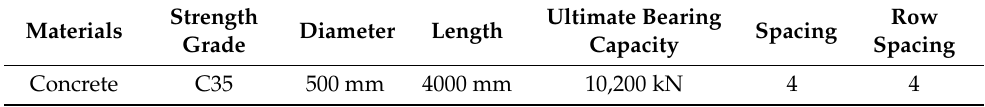
Table 3. Parameters of Φ 500 mm L 4000 mm pillars in structural